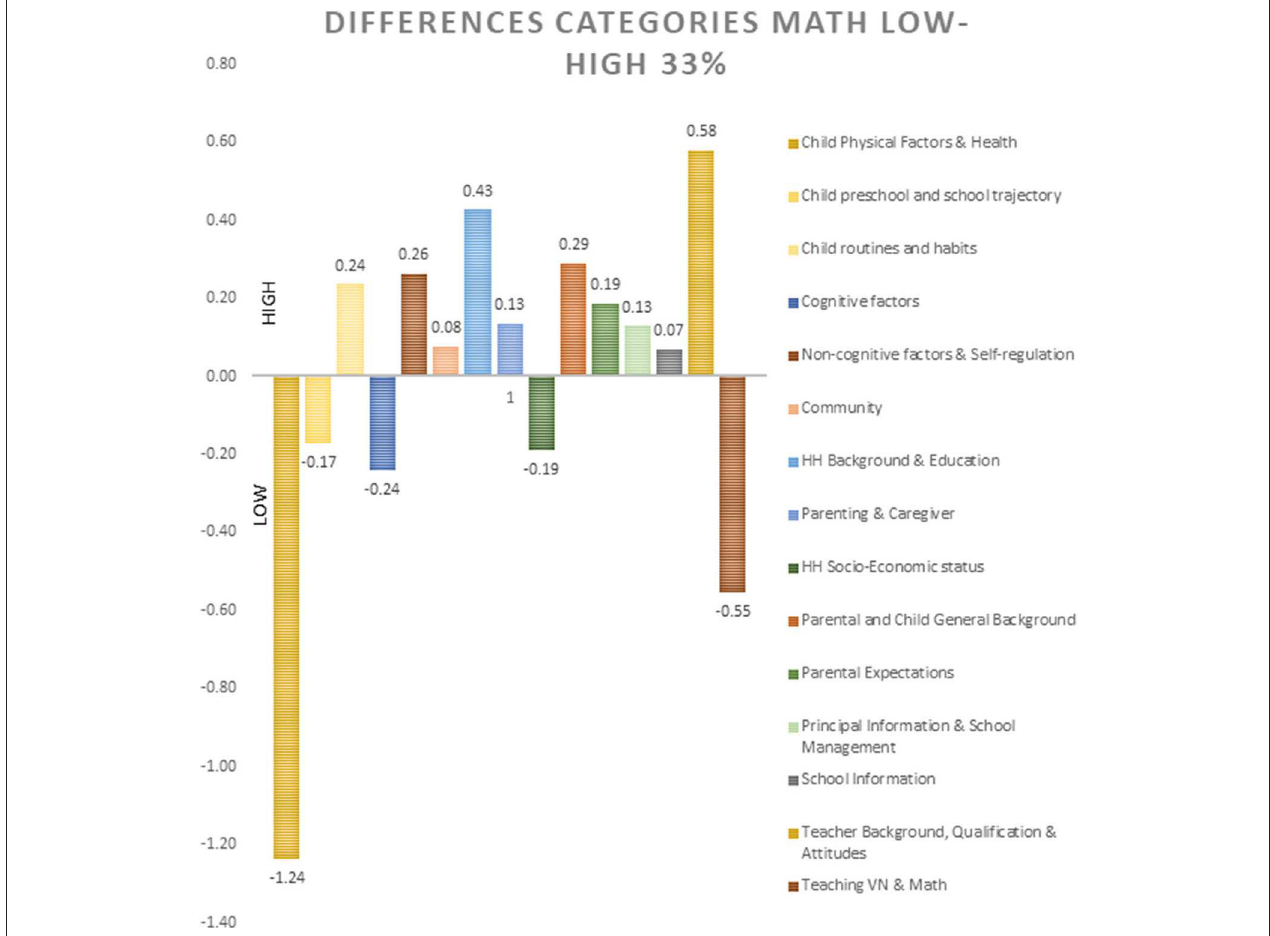
FIGURE 3 | Differential contribution of each category of variables for each math performance level, according to the observed predictive weight.